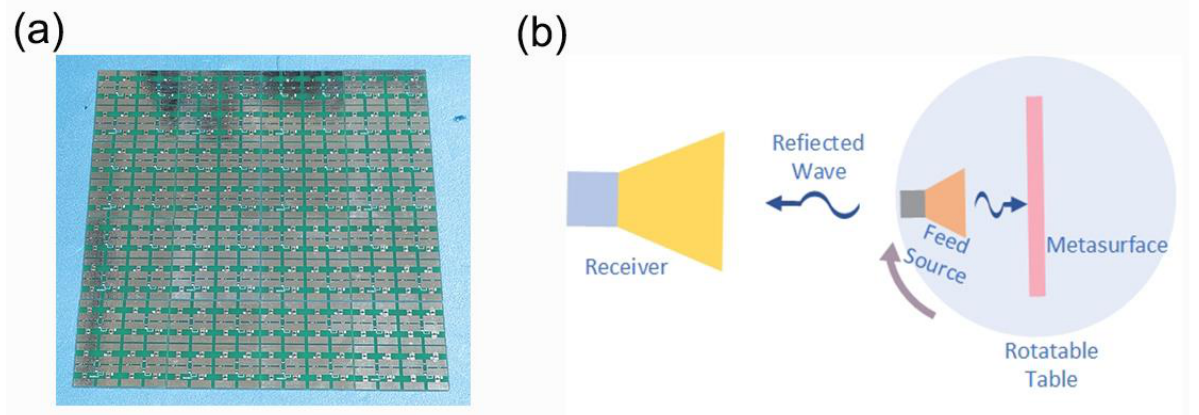
Figure 5. The sample of the metasurface and the measurement configuration for the far-field test. ( a ) The metasurface is composed of 16 × 16 units. ( b ) The measurement configuration for the far-field test.